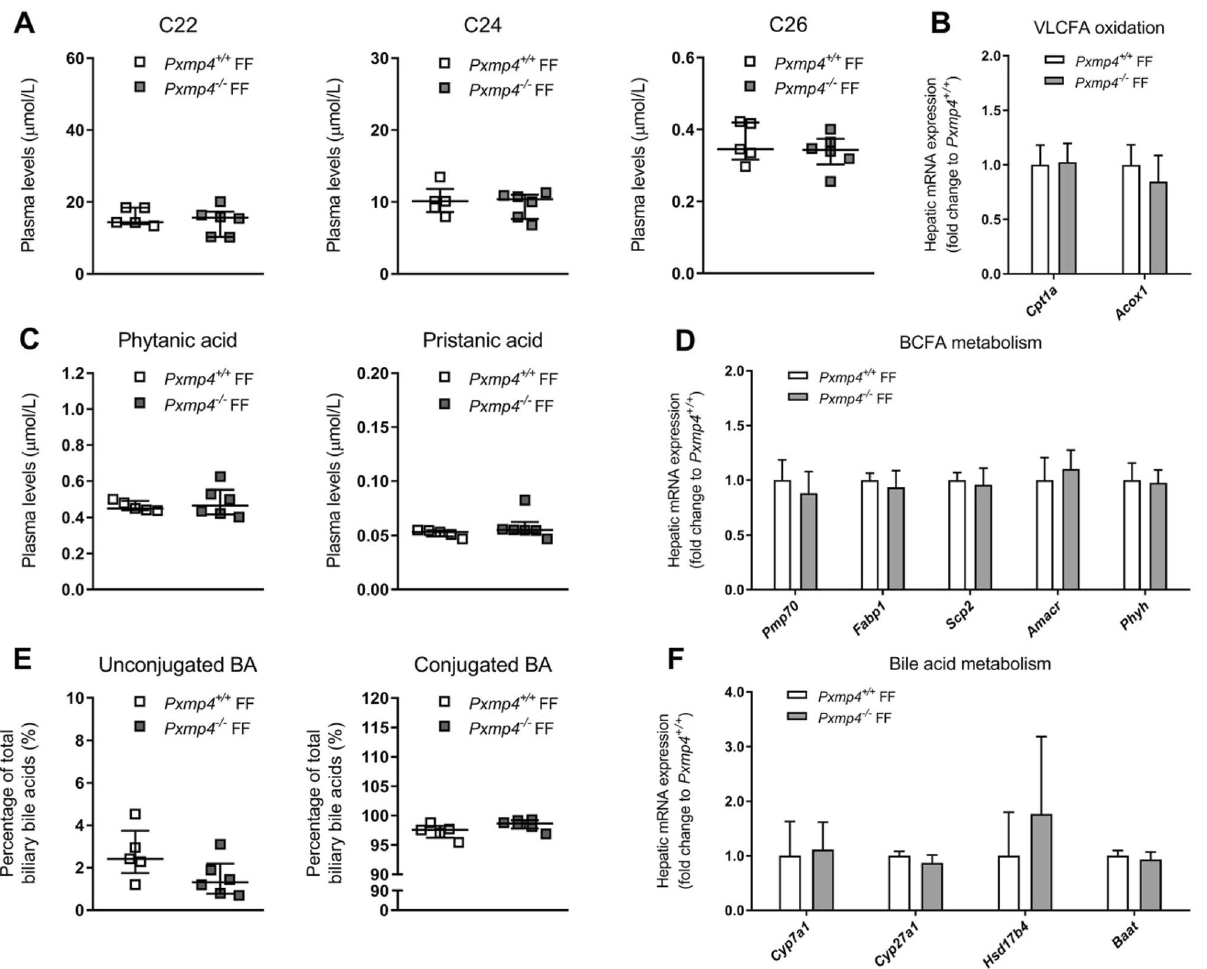
Figure 3. Effect of PXMP4 deficiency on stimulation of peroxisome function by FF. ( A ) Plasma levels of the VLCFAs docosanoic acid (C22), lignoceric acid (C24) and hexacosanoic acid (C26); ( B ) Hepatic expression of genes involved in VLCFA oxidation; ( C ) Plasma levels of phytanic and pristanic acid; ( D ) Hepatic expression of genes involved in metabolism of phytanic and pristanic acid; ( E ) Biliary unconjugated and conjugated bile acid concentrations; ( F ) Hepatic expression of genes involved in bile acid metabolism in Pxmp4 −/− mice and wild type littermates (n = 5–6). Scatter plots represent individual data with a median ± IQR and statistical significance was tested by a Mann–Whitney test. Bar plots represent mean ± SD and significance was tested by the